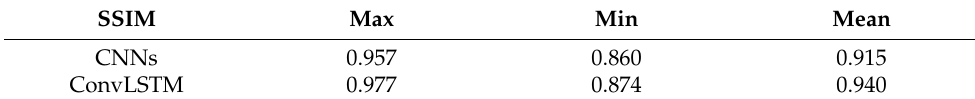
Table 2. Comparison of the SSIM between the CNNs and ConvLSTM.